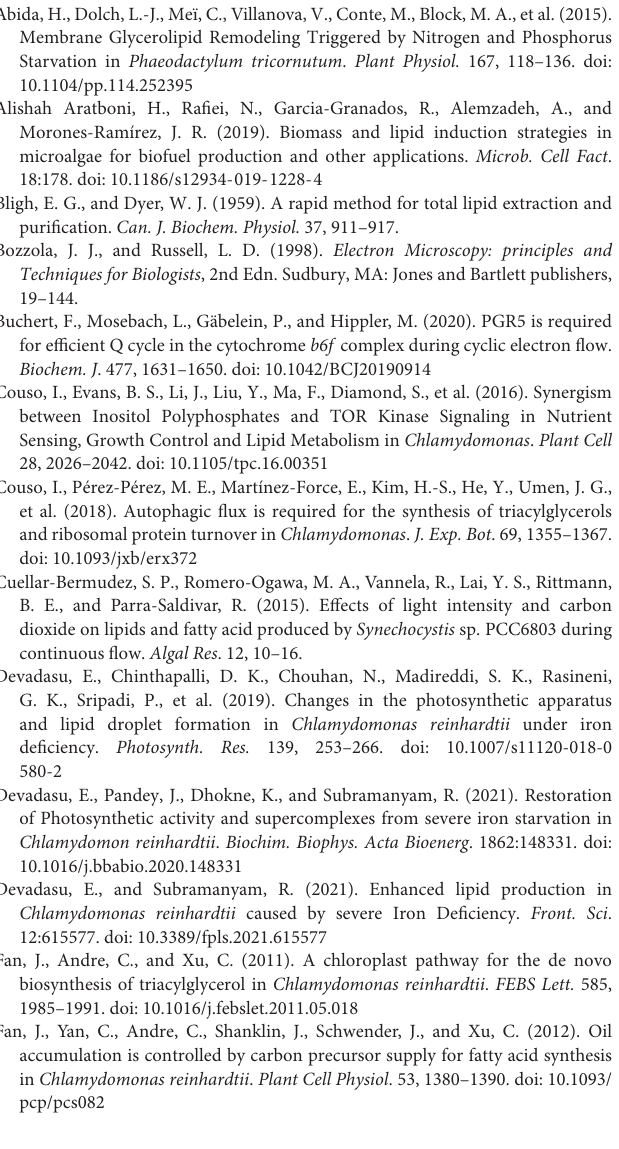
after the 3rd day of growth. Three independent experiments were conducted from each sample ( n = 3). Supplementary Figure 5 | Alteration of membrane lipid and TAG in C. reinhardtii cells grown under normal and high light conditions. (A) TLC analysis showing TAG accumulation of C. reinhardtii cells WT and mutants pgrl1 and pgr5 strains under 50 µ mol photons m − 2 s − 1 and 500 µ mol photons m − 2 s − 1 . Three independent experiments were conducted for all samples ( n = 3). (B) Separation of polar lipids by TLC from C. reinhardtii strains WT , pgrl1, and pgr5 under 50 µ mol photons m − 2 s − 1 and 500 µ mol photons m − 2 s − 1 . Polar lipids and TAG was visualized by iodine staining. Three independent experiments were conducted for all samples ( n = 3). WT, pgrl1 and pgr5 50, WT, pgrl1 and pgr5 500, represents 50 and 500 µ mol photons m − 2 s − 1 . TAG, triacylglycerol.